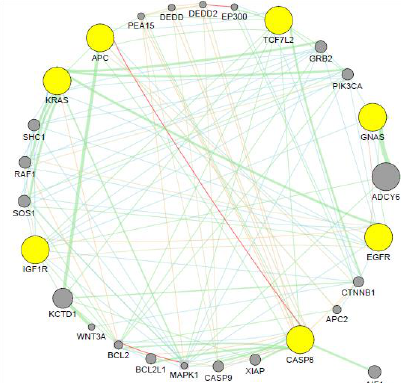
Figure 4. Co-expression analysis network of the prioritized microRNA target genes. The target genes are shown in yellow nodes while other genes in grey represent the associated genes. The red edges showed that the connected genes are co-expressed while the green edges are associated with genetic interactions. Other interactions include shared protein domains, physical interaction, pathway, and predicted interaction.